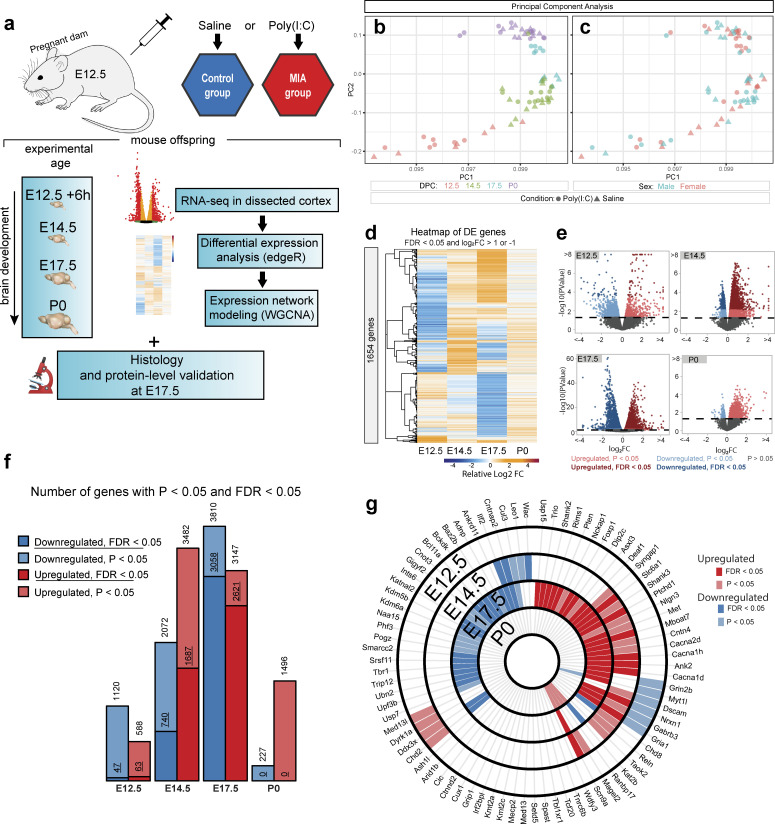
Differential expression across embryonic brain development following maternal immune activation via poly(I:C) injection at E12.5.(a) Schematic representation of MIA model and study design. E: embryonic day, P: postnatal day, IHC: immunohistochemistry, WB: western blot. Poly(I:C) was injected at E12.5. Samples for RNA-seq were collected at E12.5 + 6 hr, E14.5, E17.5, and at birth (P0). IHC and WB analysis were conducted on a separate animal cohort at E17.5 and P0. (b, c) Principal component analysis (PCA) of RNA-seq data indicates that developmental age accounts for the majority of variance across samples. Age (DPC) or sex are represented as colored symbols in (b) and (c) respectively, and poly(I:C) or saline treatment indicated by circles or triangles, respectively (d) Heatmap representing relative gene expression changes between control and MIA samples across time-points. Hierarchical clustering by relative fold changes shows stage-specific differential expression signatures (DE genes shown have FDR < 0.05 and log2 fold change (log2FC)>1 or < −1). (e) Volcano plots of DE effect size and significance show stage-specific differences in number of DE genes and DE effect size, with the strongest dysregulation at E17.5. Colors represent directionality and statistical significance. (f) Numbers of upregulated and downregulated DE genes at FDR < 0.05 and p<0.05 thresholds again show varying DE genes numbers with a peak of dysregulated genes at E17.5. (g) Intersection of stage-specific DE genes with the 82 SFARI autism-associated mouse gene orthologs that were expressed at measurable levels in the RNA-seq data. E17.5 DE genes (FDR < 0.05) were enriched for SFARI genes (p=3.9e-04, hypergeometric test). Concentric circles represent developmental time-points. Light red, upregulated DE genes (p<0.05); dark red, upregulated DE genes (FDR < 0.05); light blue, downregulated DE genes (p<0.05); dark blue, downregulated DE genes (FDR < 0.05).